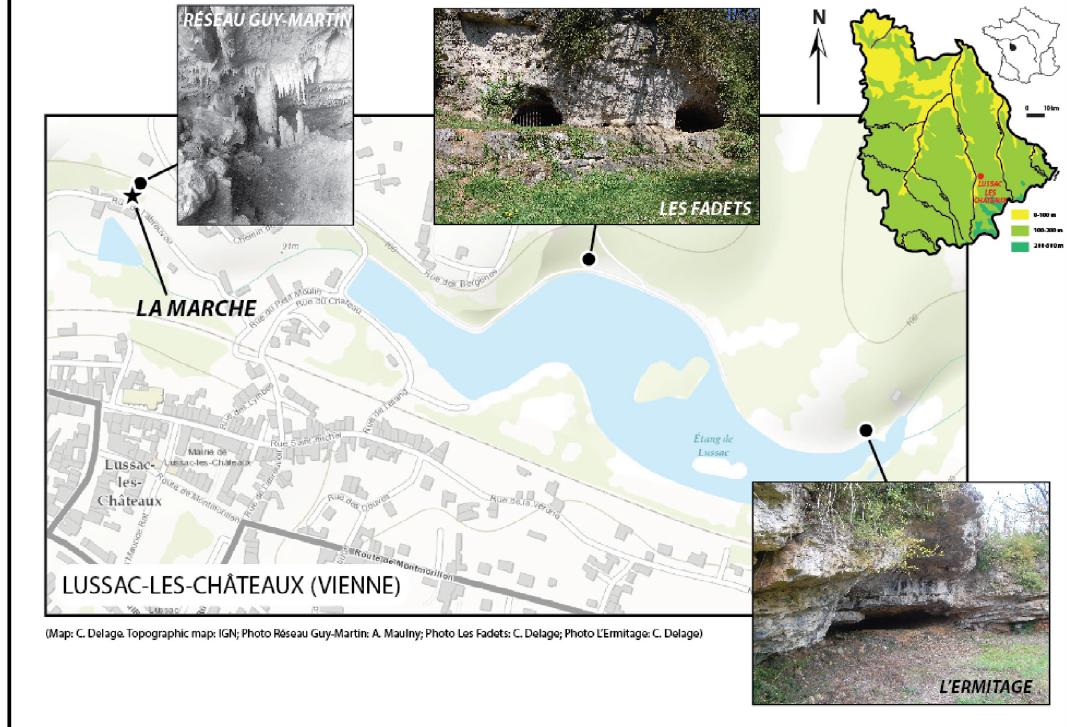
Figure 1. Map with the location of the prehistoric sites in Lussac-les-Châteaux mentioned in the